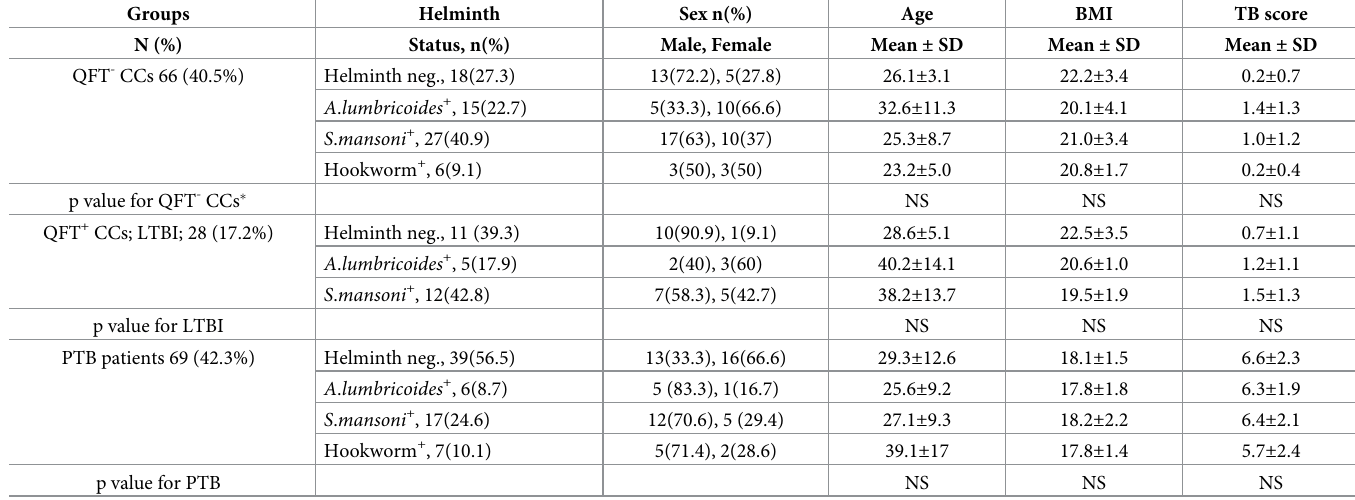
N, number; neg., negative; BMI, body mass index; QFT, QuantiFERON test; PTB, pulmonary tuberculosis; CCs, community controls; LTBI, latent tuberculosis infection; NS, non-significant. � The p-value represents comparison of means using one way ANOVA between helminth negative, A . lumbricoides + , S . mansoni + and hookworm + groups of QFT - CCs, LTBI and PTB